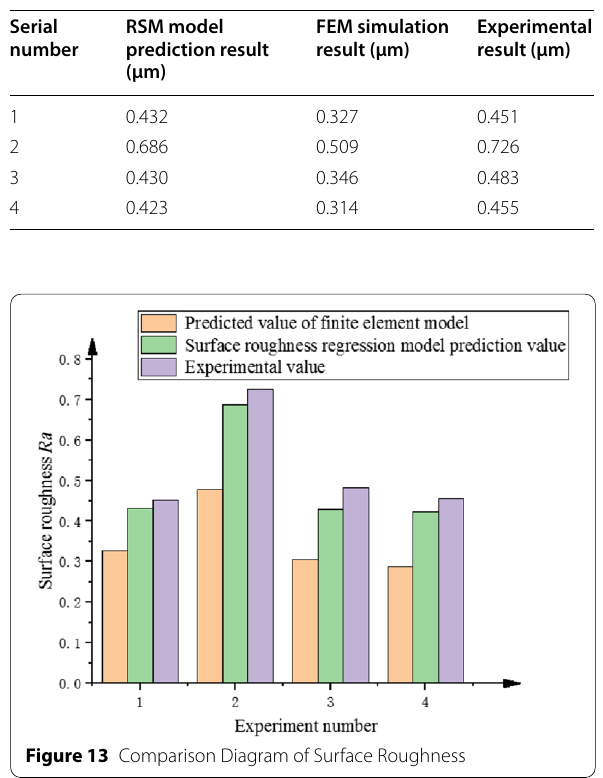
Figure 13 Comparison Diagram of Surface